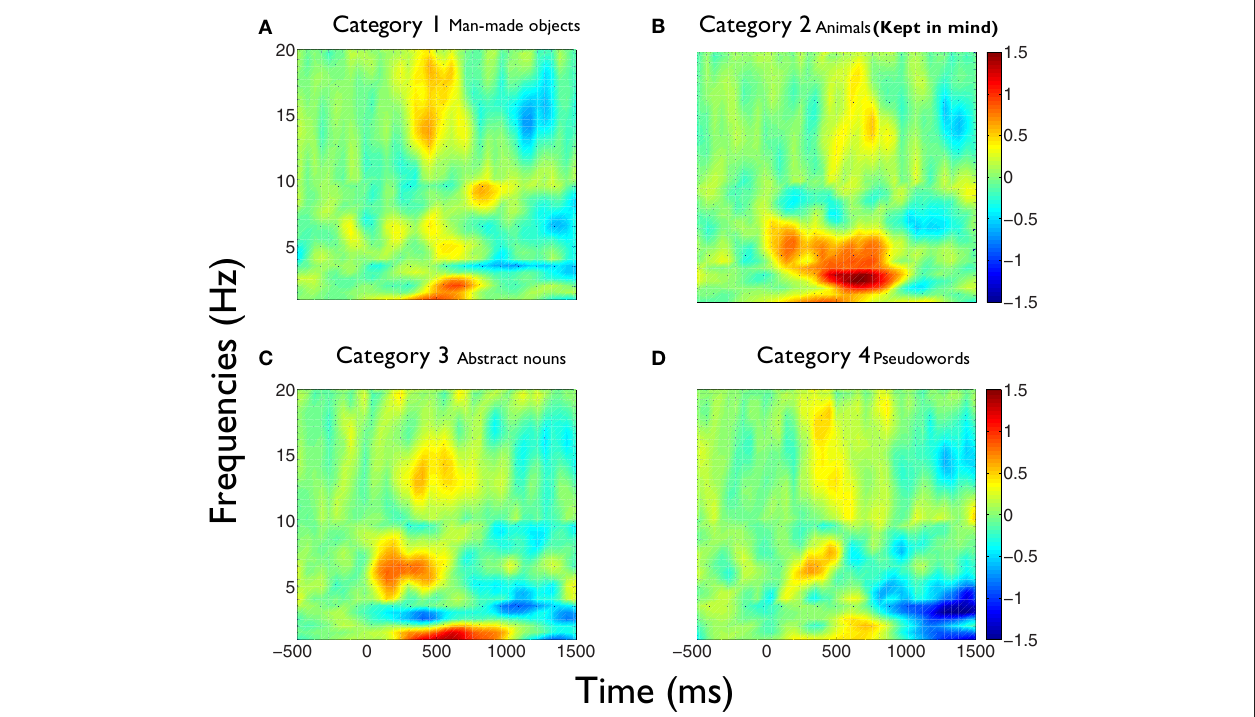
FIGURE 1 | Phase synchronization increments during semantic analysis are larger for the kept in mind category in delta and theta frequency bands. Average time-frequency charts of the phase synchronization changes ( Z -scores) obtained during the task, for each category [ (A) category 1, i.e., man-made objects; (B) category 2, i.e., animals; (C) category 3, i.e., abstract nouns; (D) category 4, i.e., pseudo-words]. (B) Corresponds to the kept in